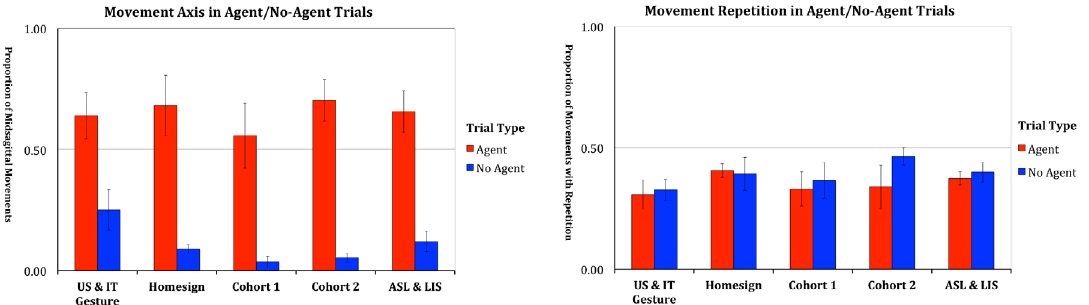
Fig. 4. The proportion of responses with Midsagittal movement (left graph) and responses with Movements with repetition (right graph) in Agent (red bars) and No-agent vignettes (blue bars) produced by Silent Gesturers, Homesigners, NSL Cohort 1 signers, NSL Cohort 2 signers, and ASL/ LIS signers. Error bars indicate standard